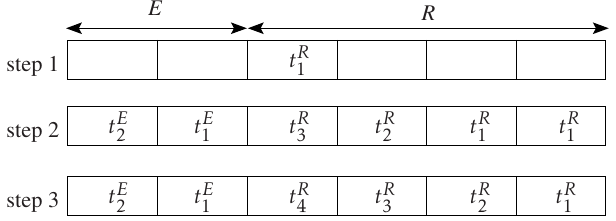
Figure 3. Example of the state of the E and R lists, at three different